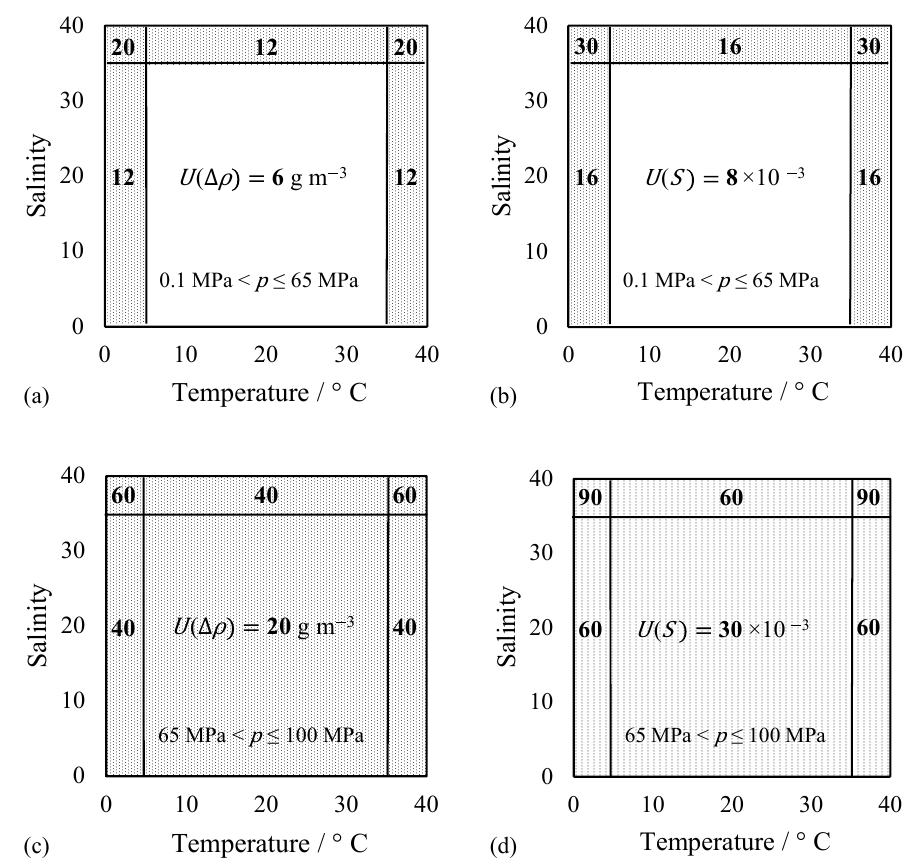
Figure 9. Uncertainty in the density–salinity relation at high pressures. Uncertainty in the relative density of air-saturated seawater, U((cid:49)ρ SW ) , that results from a calculation using salinity and temperature values for pressures (a) up to 65MPa and (c) up to 100MPa. Uncertainty in salinity, U(S) , that results from an inverse calculation using the relative density of air-saturated seawater and temperature values for pressures (b) up to 65MPa and (d) up to 100MPa. The white area indicates the interpolation region equal to that of the data set used for fitting. The grey area indicates the extrapolation